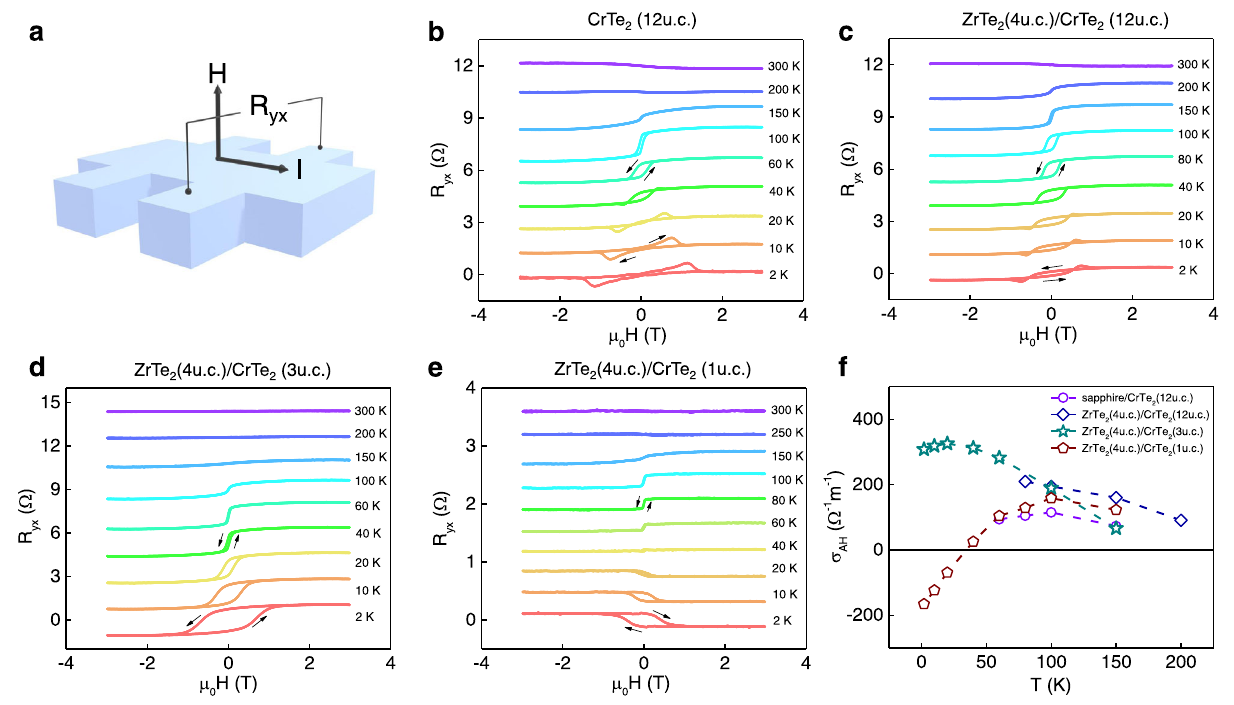
Fig. 3 Anomalous Hall resistance measurements on CrTe 2 layers and ZrTe 2 /CrTe 2 heterostructure. a Schematics of the Hall bar. b – e Anomalous Hall resistance (AHR) of the 12u.c. CrTe 2 ( b ), ZrTe 2 (4u.c.)/CrTe 2 (12u.c.) ( c ), ZrTe 2 (4u.c.)/CrTe 2 (3u.c.) ( d ), and ZrTe 2 (4u.c.)/CrTe 2 (1u.c.) ( e ). The AH resistance data has been offset for clarity. The arrows denote the fi eld sweep directions. f Anomalous Hall conductivity of the samples shown from b to e